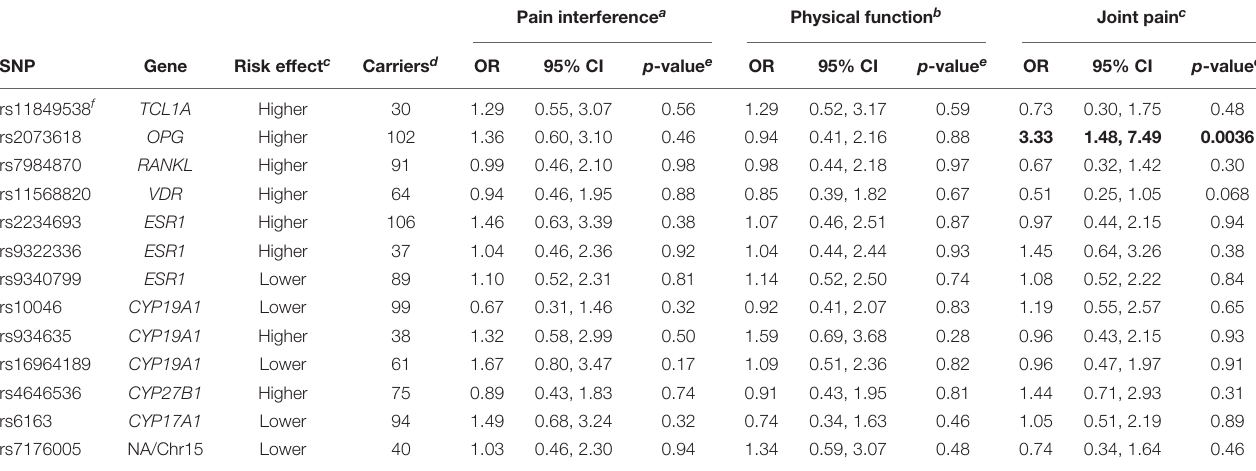
TABLE 2 | Unadjusted genetic associations for each variant with AIMSS endpoints. Pain interference a Physical function b Joint pain c